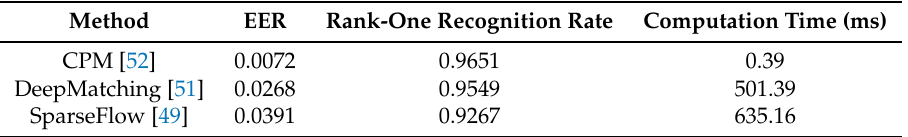
Table 8. Comparison of results of different sparse matching methods on a CASIA-MS-PalmprintV1 database.